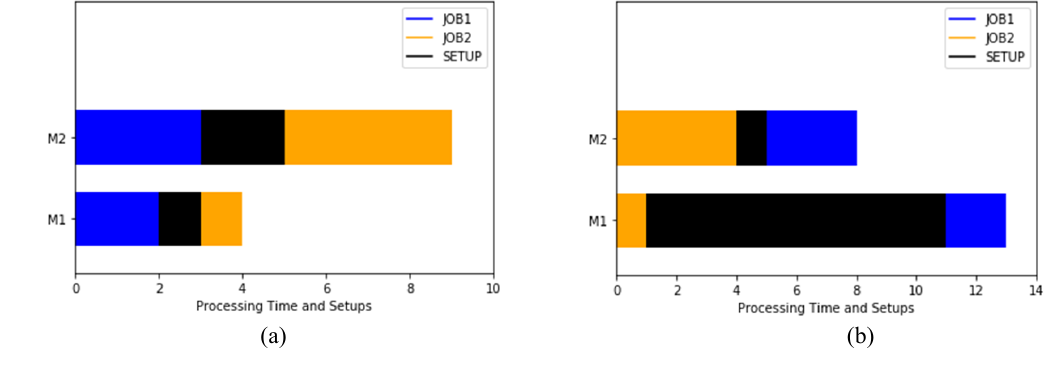
Fig. 1. Solutions with fixed